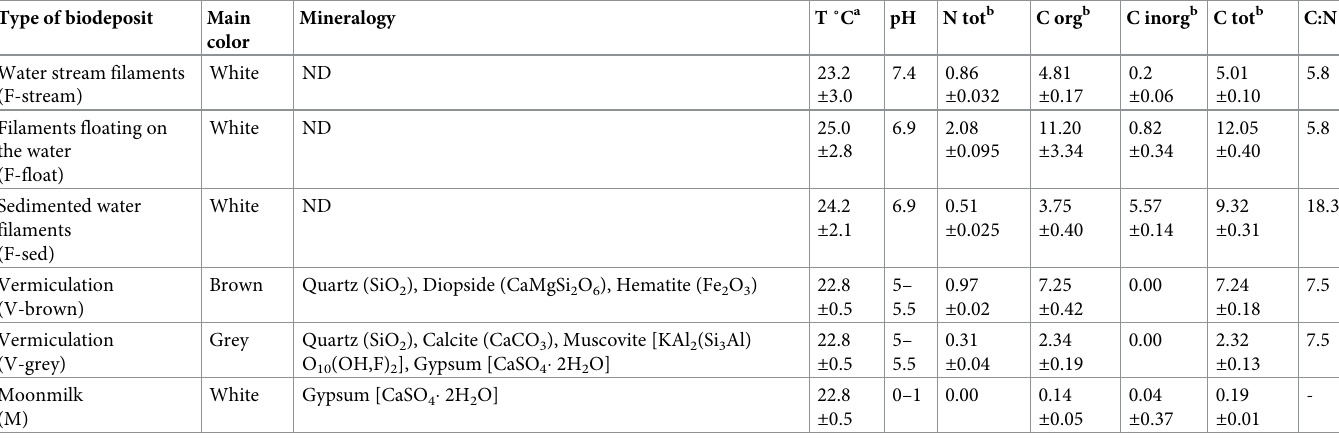
Table 2. Physico-chemical properties and composition of the Fetida Cave biofilms and deposits.